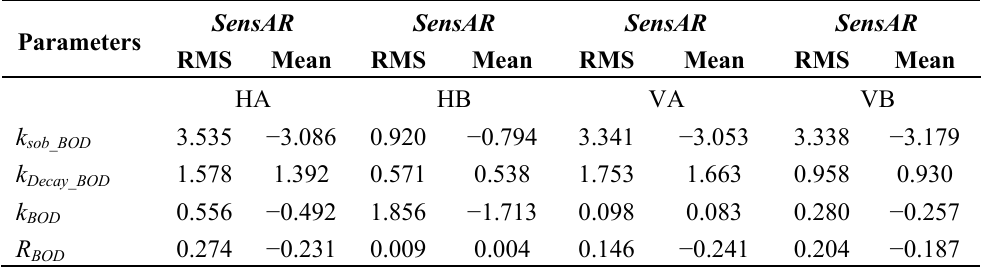
Table 8. Results of sensitivity analysis of BOD removal quantity from all biochemical processes in the simulated